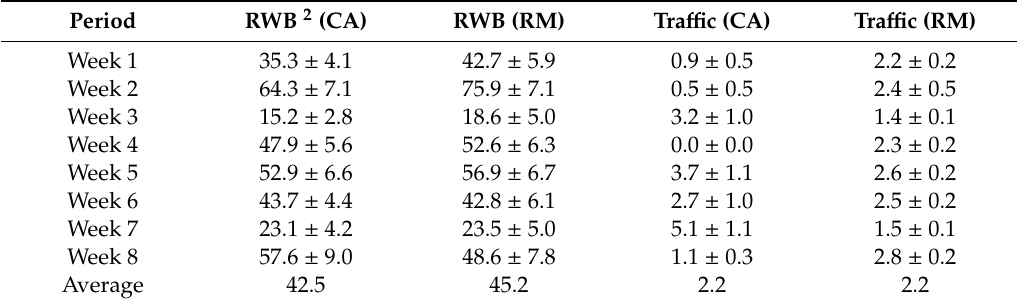
Table 2. Comparison for cluster analysis (CA) and receptor model (RM) source apportionment estimates ( ± standard error) for Temuco, July–September 2014 1 in ( µ g / m 3